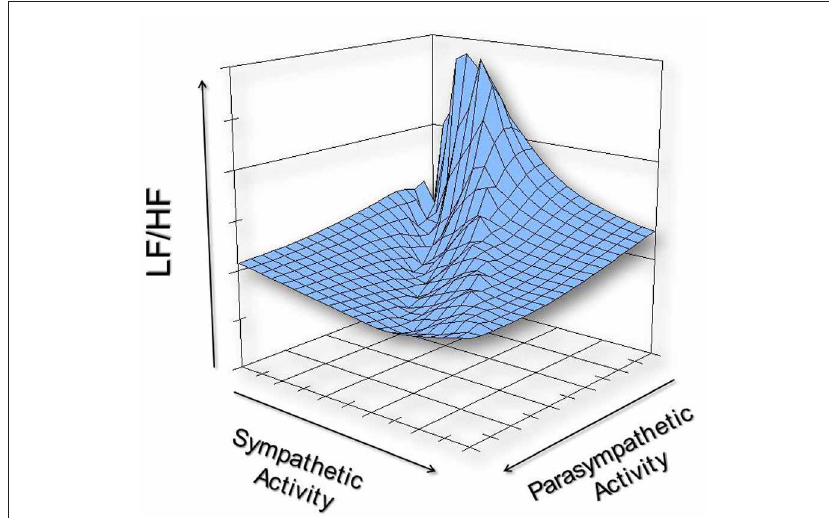
FIGURE 1 | An illustration of the possible non-linear effects of varying cardiac sympathetic and cardiac parasympathetic nerve activity on LF/HF. This graph was constructed using the following formula (derived from a synthesis of the literature, particularly Randall et al., 1991; Taylor et al., 2001; Cohen and Taylor, 2002): LF/HF = (0.5 parasympathetic + 0.25 sympathetic nerve activity)/(0.9 parasympathetic + 0.1 sympathetic nerve activity). The nerve activity was varied from baseline (1 arbitrary unit each) increasing or decreasing by up to a factor of 10 (i.e., from 0.1 to 10